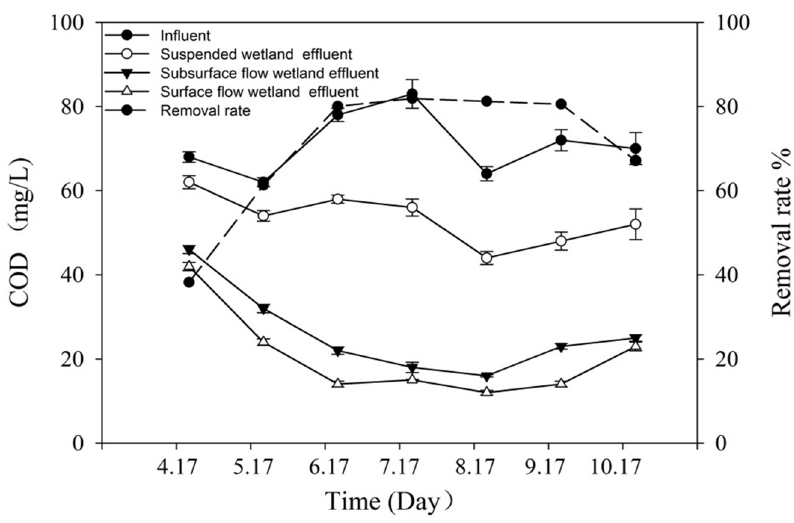
Figure 5. COD concentration of the inflow and outflow and the removal rate.